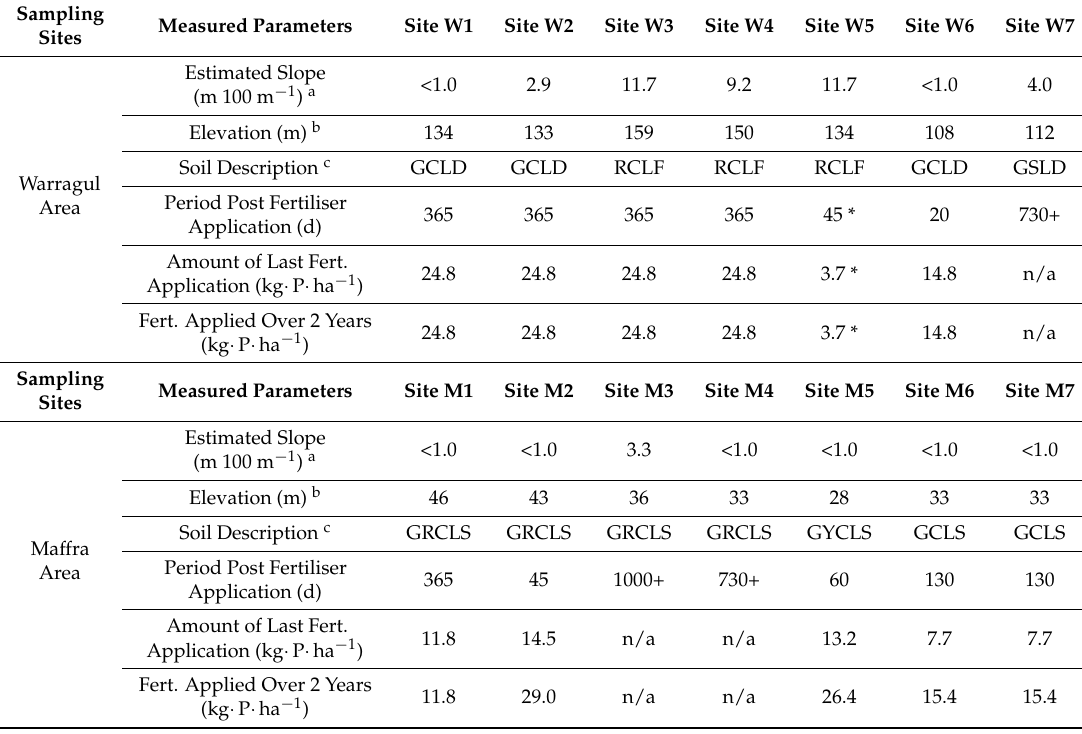
Table 1. Information for individual sampling sites of the Warragul and Maffra